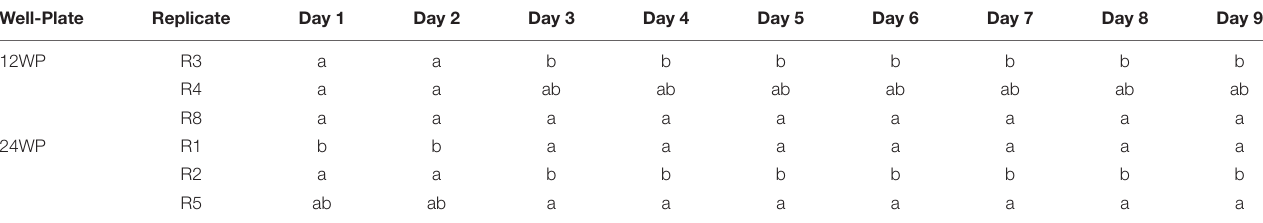
Different letters indicate significant differences in green area (pixels) of 4 DAG old Arabidopsis grown in 1 × MS medium over time for selected replicates of 12-well plates and 24-well plates according to Conover’s test after a Kruskal–Wallis test (p < 0.05).